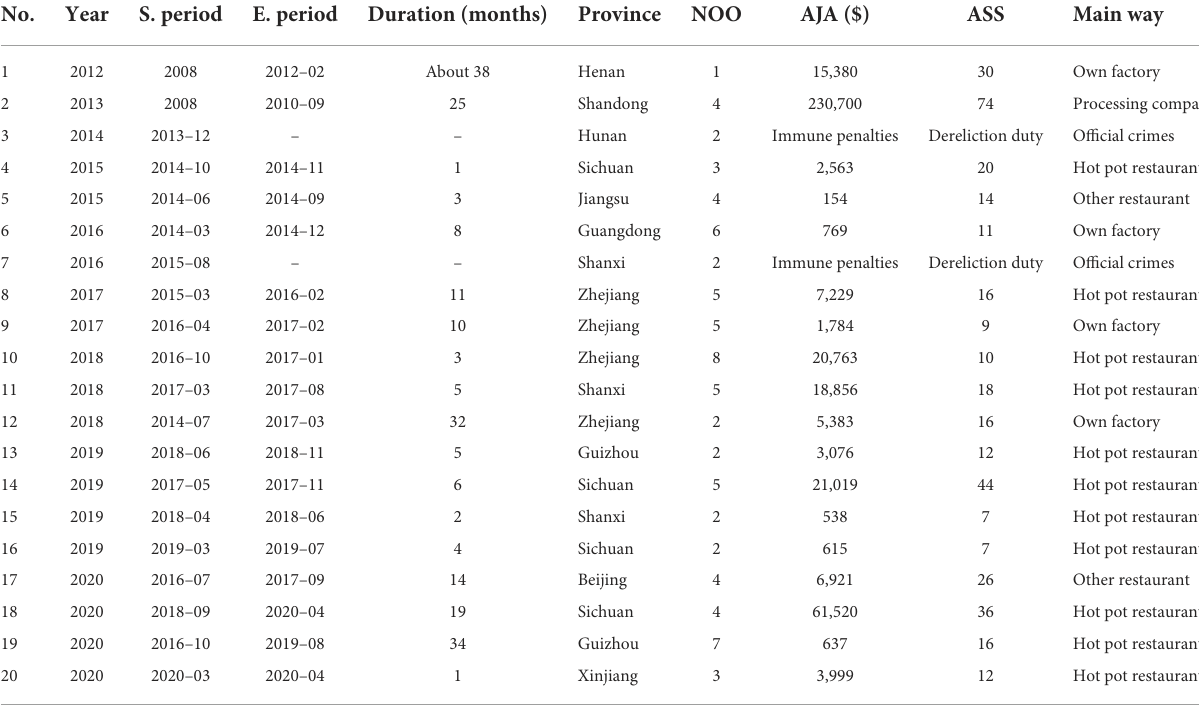
TABLE 1 Specific information for 20 of the 152 encoded judgments from China Judgments Online.